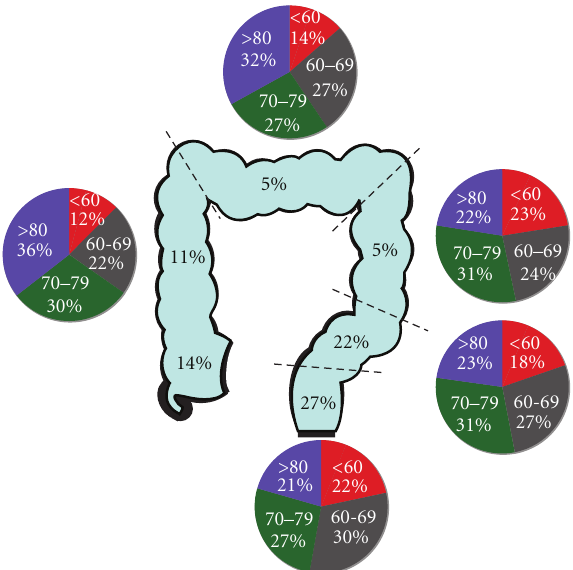
Figure 1: Epidemiology of colorectal cancer by primary tumour site (distribution of tumour sites from UK national statistics (http:// info.cancerresearchuk.org/cancerstats/types/bowel/incidence/uk- bowel-cancer-incidence-statistics; age distribution by tumour site from Hemminiki et al.